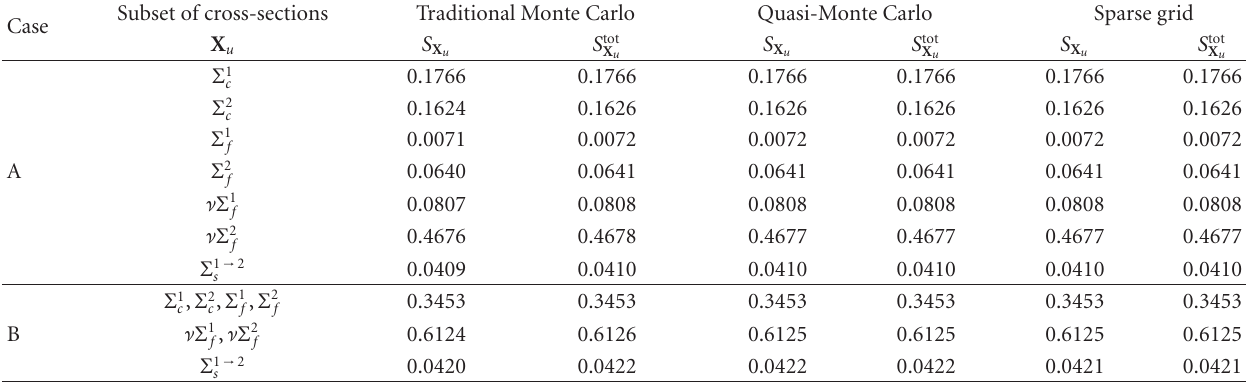
Table 4: Estimated sensitivities of the infinite multiplication factor to di ff erent cross-sections (Case A) or their subsets (Case B). Subset of Case